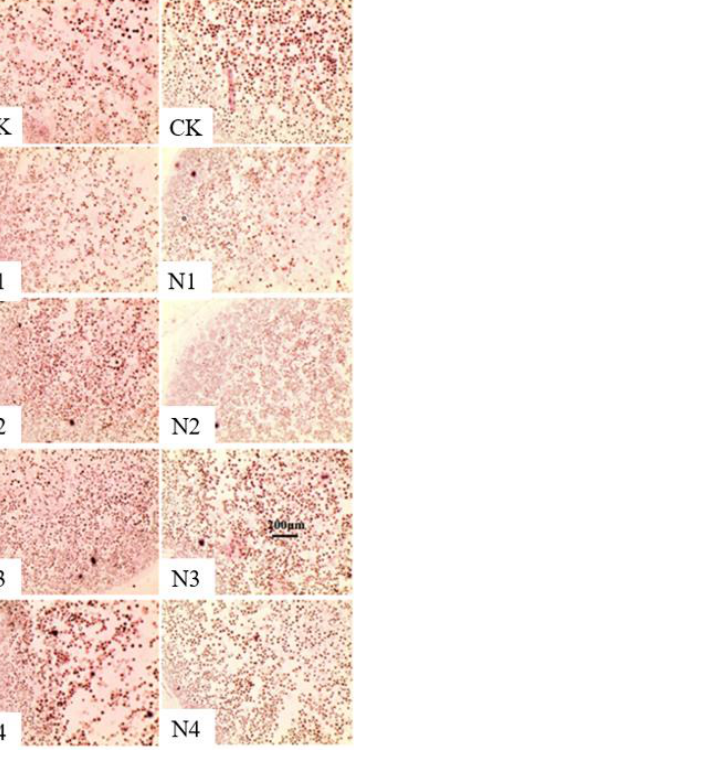
Figure 5. Starch granule in endosperm cell in different treatments at 15 days after silking in 2016. CK means a single application of N at sowing; N1, N2, N3, and N4 indicate four treatments of late split N application based on different application times and ratios of N input. A black dot represents a starch grain, and the scale bar indicates 200 µm. Table 3. Effects of N treatments on grain-filling parameters in summer maize.